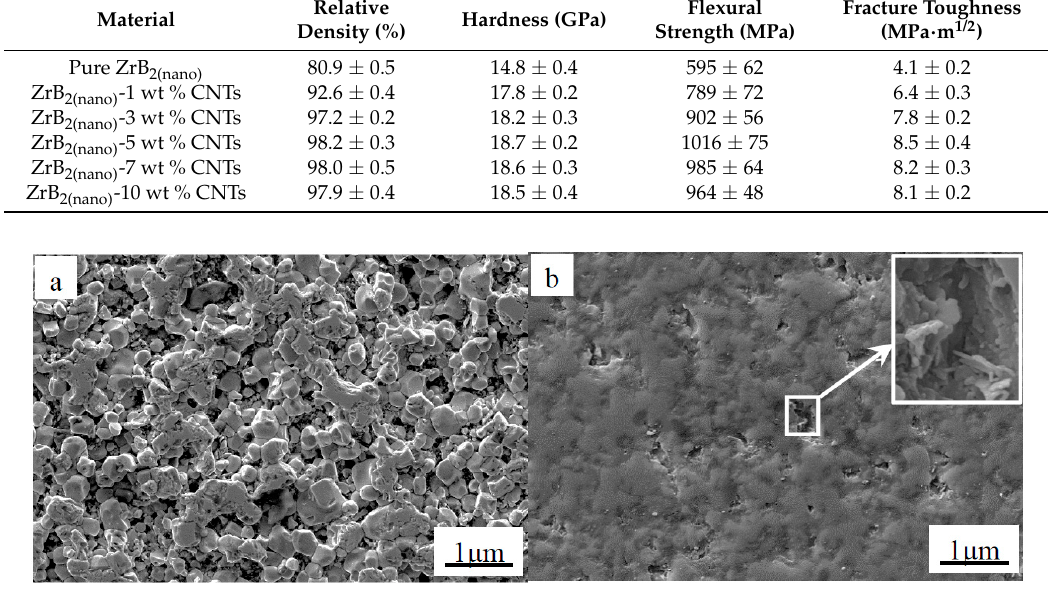
Figure 2. Secondary electron SEM images of the polished surface of as-sintered ( a ) monolithic ZrB 2(nano) and ( b ) ZrB 2(nano) -5 wt % CNTs composite. Table 2. Density and mechanical properties of ZrB 2(micro) - y wt % CNTs composites.